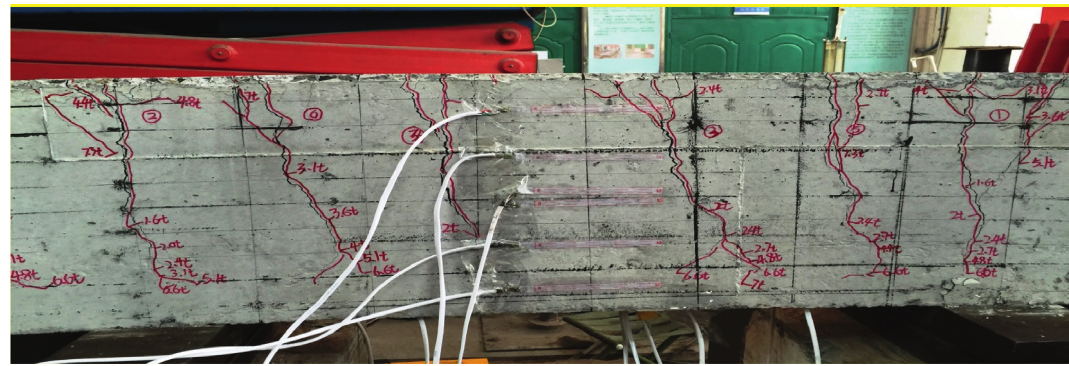
Figure 4: Actual failure mode of the RC